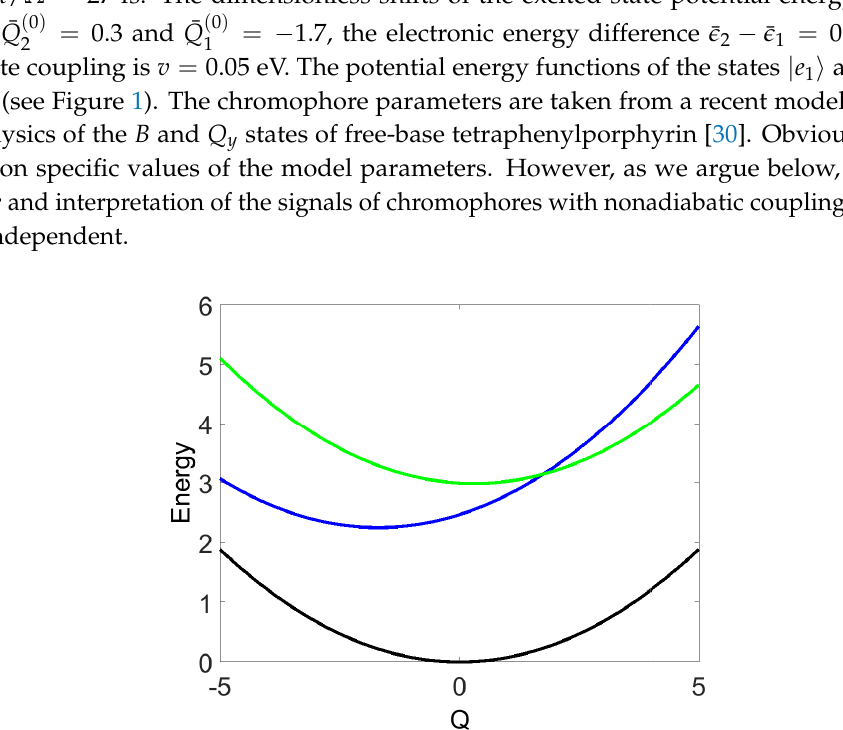
(cid:105) (blue) and | e (cid:105) 2 1